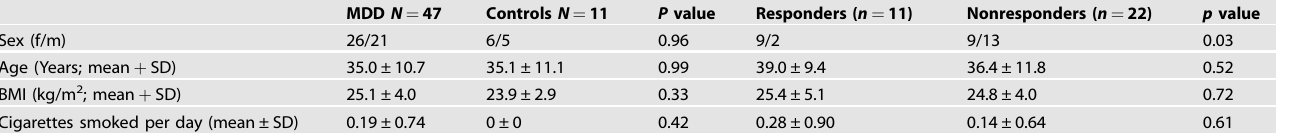
Table 1. Demographic characteristics of subjects with MDD and